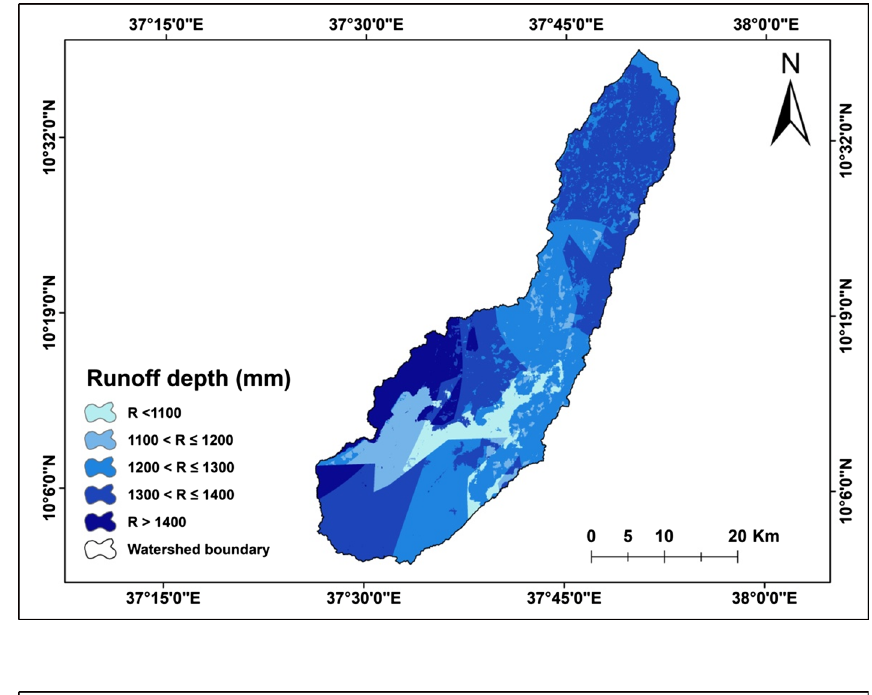
Fig. 9 Geological formation map of the study